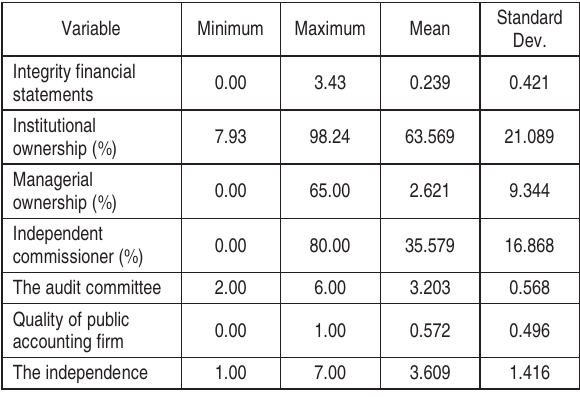
Table 2. Descriptive statistics of variables N=138